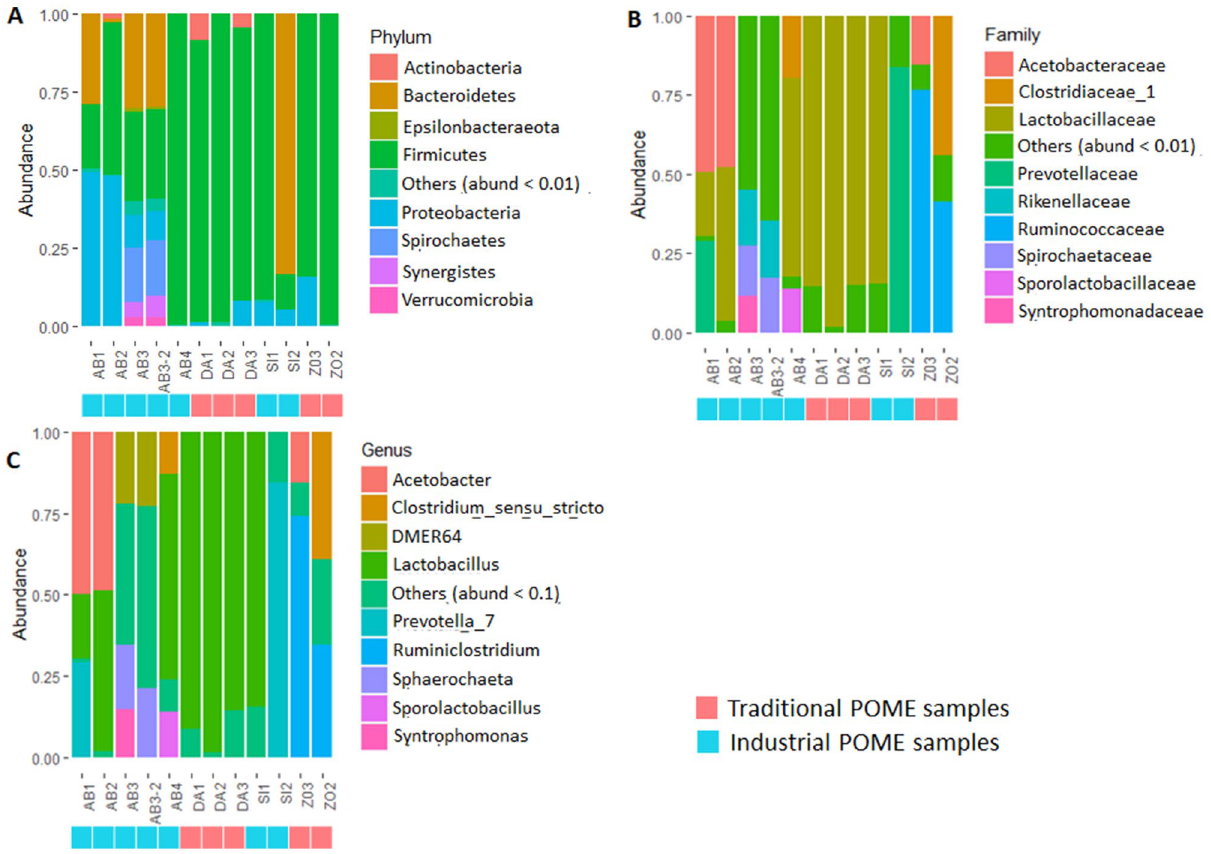
Figure 2. The taxon bar chart shows the relative abundance (%) of predominant bacteria at phylum level ( A ) family-level ( B ) and genus-level ( C ). The taxa with a mean relative abundance of less than 1% across the samples are combined and shown as others. The unclassified ASV were shown as